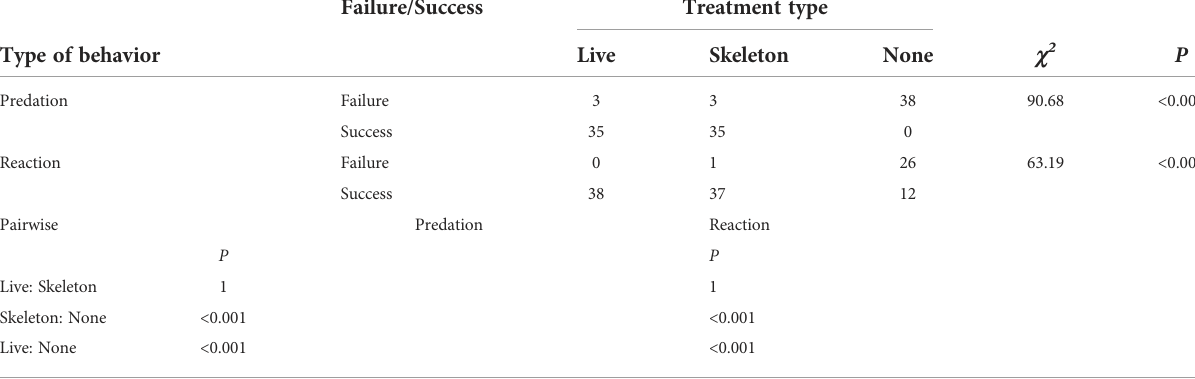
TABLE 1 Pearson ’ s Chi-square followed by Fisher exact pairwise tests of independence for nominal data analyses of predation and reaction behaviors (failure/success) of Trapezia cymodoce individuals subjected to three experimental set-ups: with live corals ( ‘ live ’ ); with coral skeletons ( ‘ skeleton ’ ); and without corals ( ‘ none ’ ), following the introduction of live Artemia .